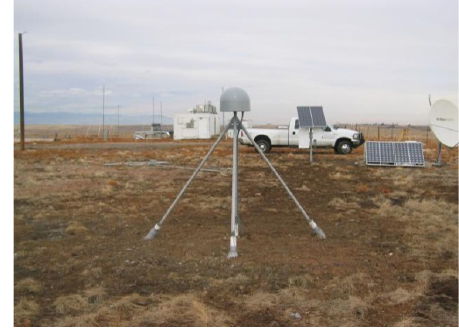
Figure 1. Surround environment of P041